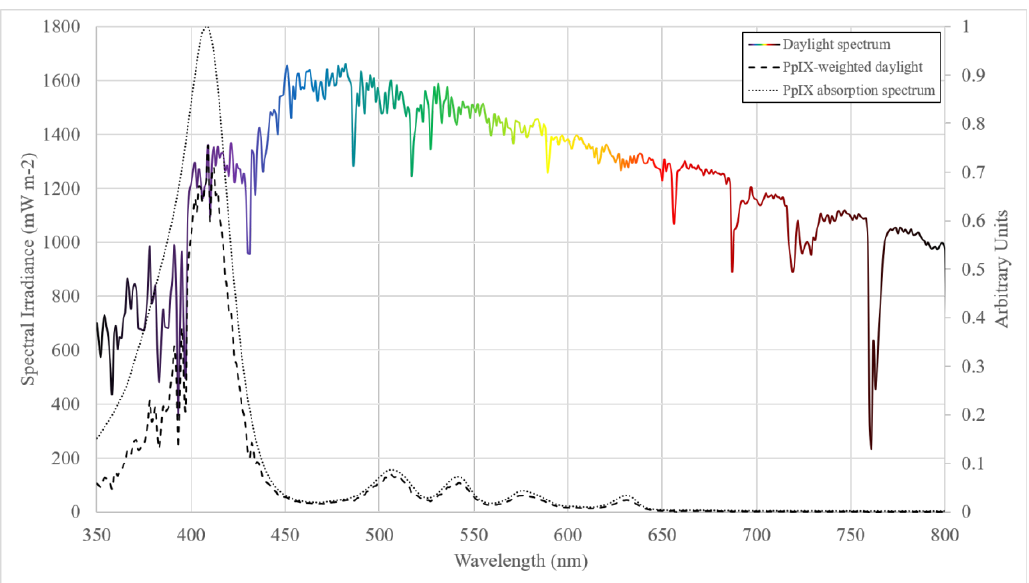
Figure 2. Multicoloured line: example daylight spectrum (12:20 h, 8 June 2019, Chilton UK). The relative spectral content of the daylight spectrum changes with the position of the sun in the sky and atmospheric conditions. Short dash line: the absorption spectrum of PpIX [25]. Long dash line, the PpIX-weighted spectral irradiance of daylight.